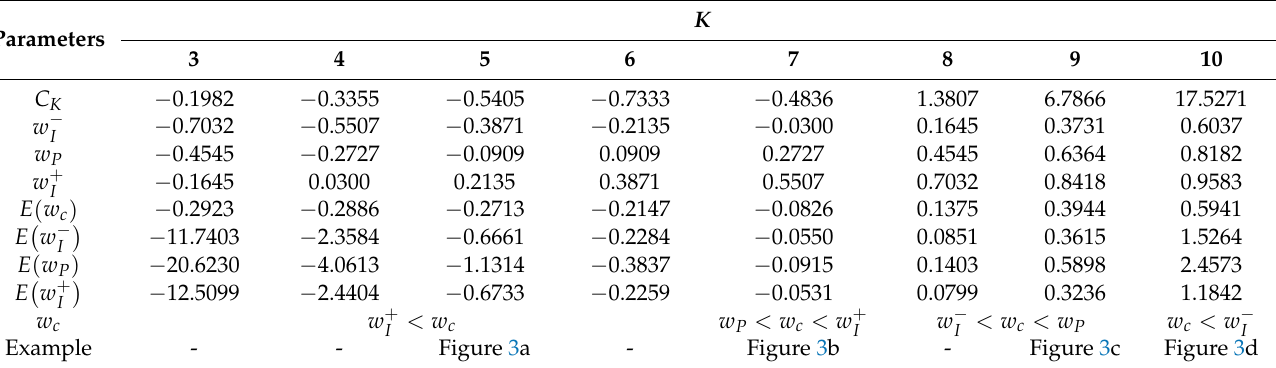
Figure 2. E ( w ) due to increasing K for N = 11 and w c = 0.4 ( ω c = 0.369 π ). Figure 2. Ε (𝑤) due to increasing 𝐾 for 𝑁 = 11 and 𝑤 𝑐 = 0.4 ( 𝜔 𝑐 = 0.369𝜋 ). Table 1. Related parameters of Figures 2 and Table 1. Related parameters of Figures 2 and 3.